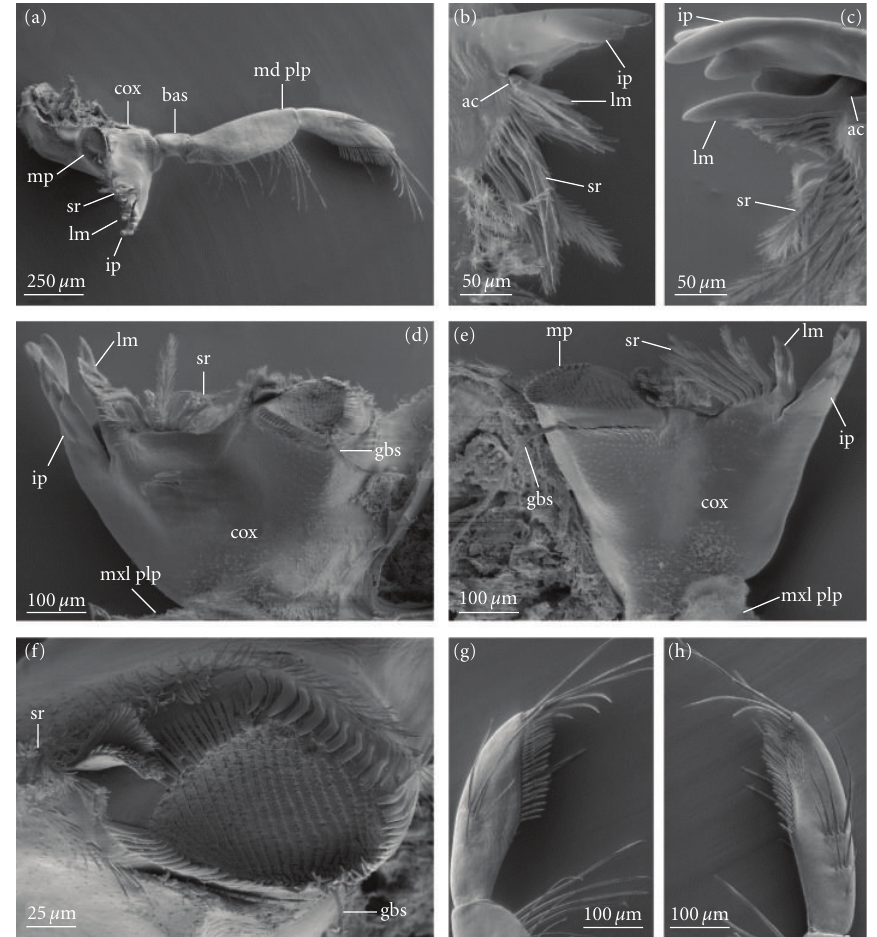
Figure 16: SEM images of mandibles of Echinogammarus berilloni : (a) left mandible in median view; (b) incisor process, lacinia mobilis, and setal row of right mandible in posterior view; (c) incisor process, lacinia mobilis, and setal row of left mandible in posterior view; (d) coxa of left mandible in anterior view; (e) coxa of right mandible in anterior view; (f) molar of left mandible in median view; (g) distal portion of left mandibular palp in median view; (h) distal portion of left mandibular palp in lateral view.